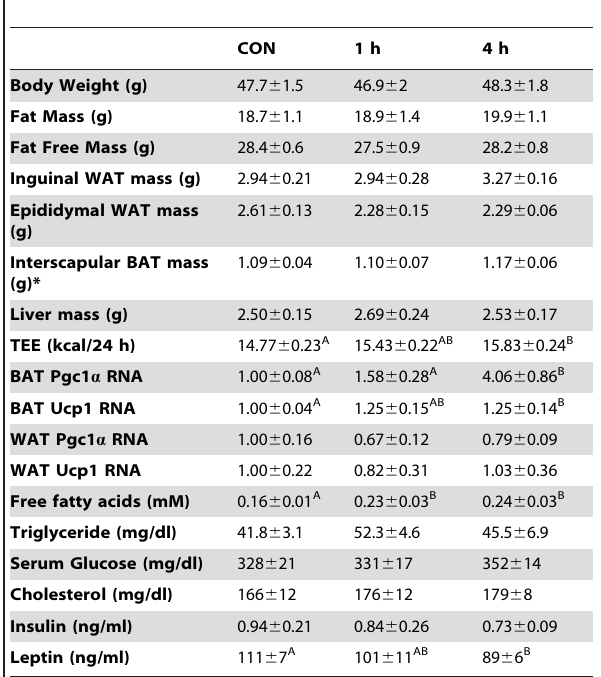
Table 1. ICE # 1, effect of 1 hour and 4 hours of cold exposure three times per week.